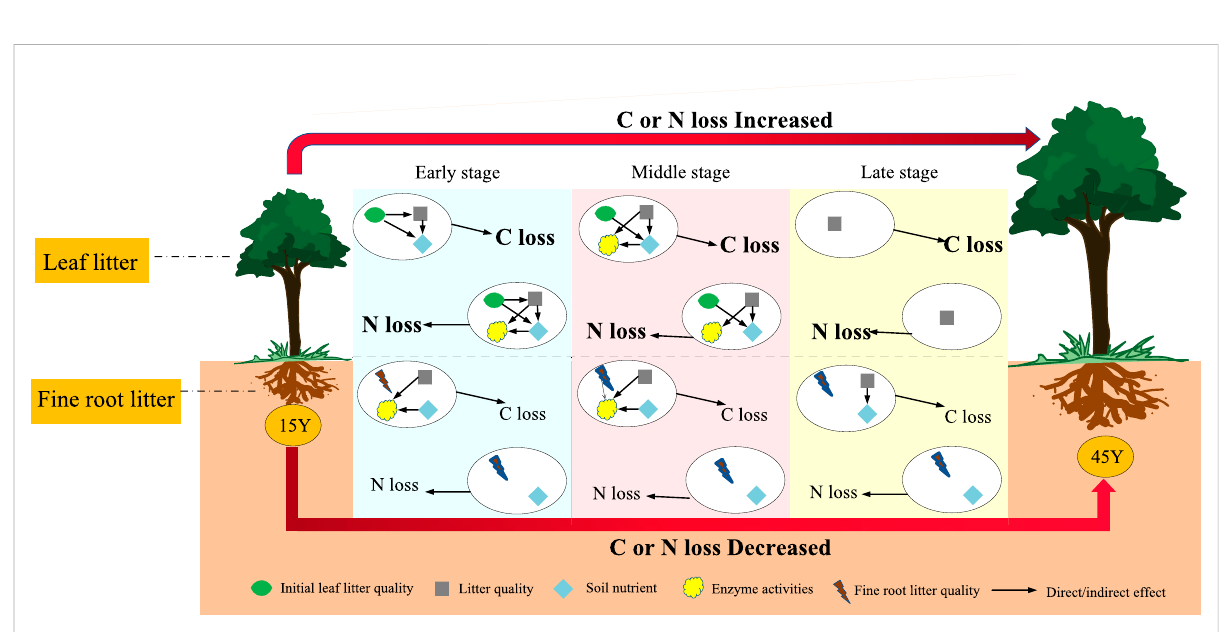
FIGURE 8 SchematicdiagramofcarbonandnitrogenlossesofRobiniapseudoacacialeafand fi nerootlitterindifferentrestoration durations. 15 Yto45 Y represent stand ages from 15 years to 45 years. The early stage, middle stage and late stage represent three different decomposition stages. All factors in the ovals (initial litter quality, litter quality, the soil environment and enzyme activities) changed with decomposition stage, which showed the difference in relative importance. The C and N losses in leaf litter are in bold, which indicated that the C or N losses in leaf litter were signi fi cantly higher than those in root